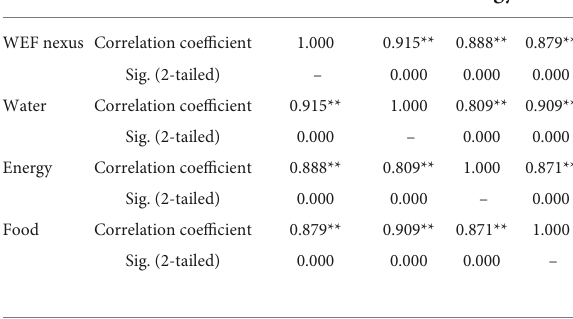
TABLE 5 Spearman correlation coefficient of transfer